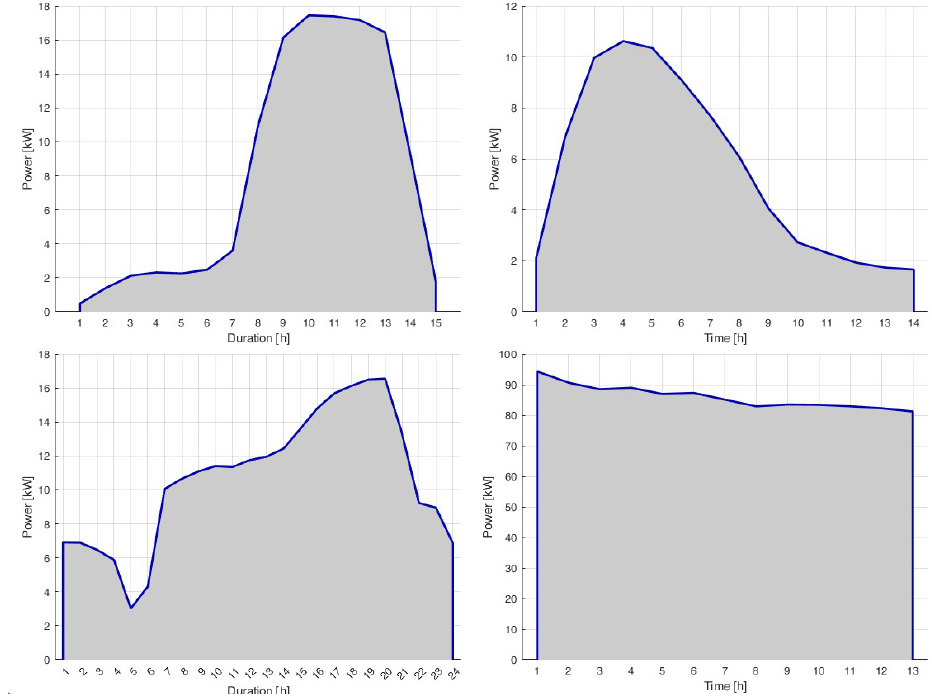
Figure 6. Examples of shiftable loads. The x axis represents the duration of the load in